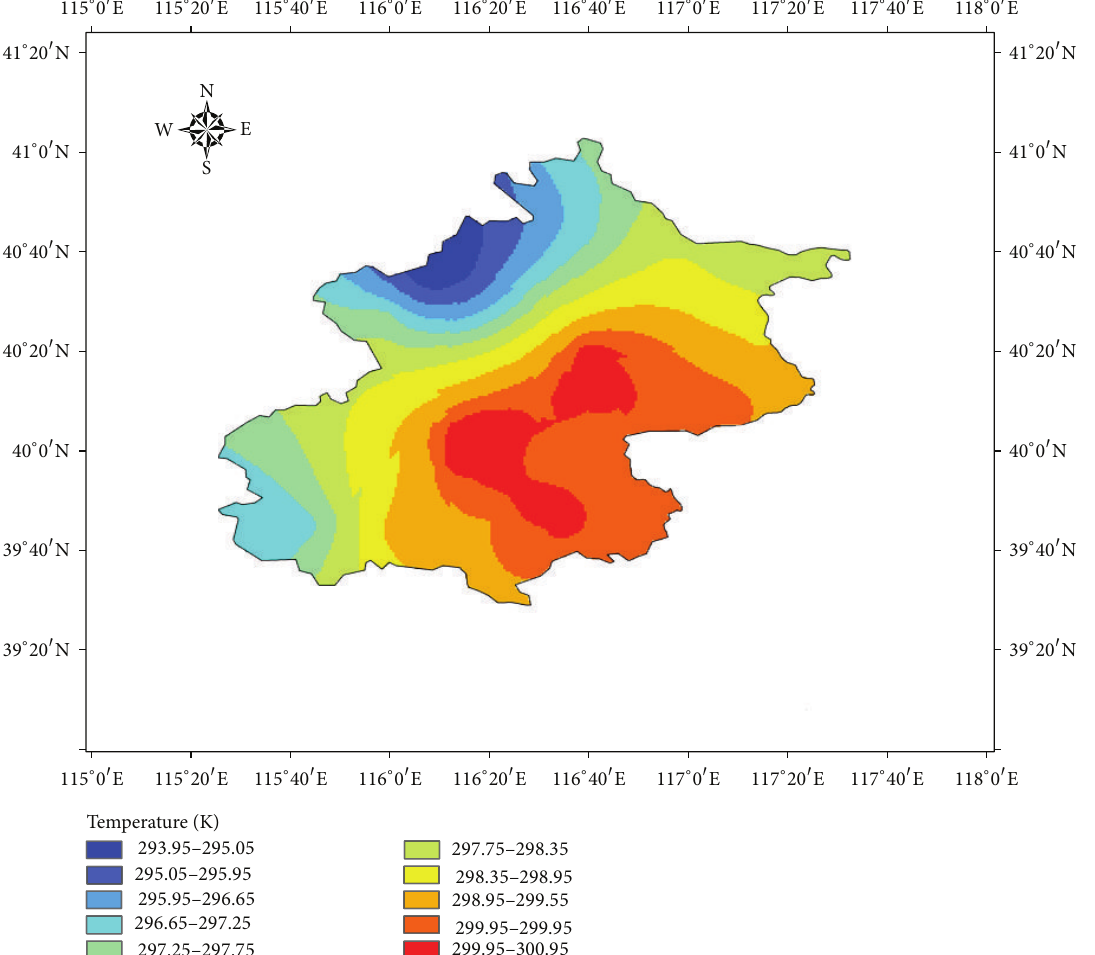
Figure 3: Spatial distribution of the observed daily mean temperature (K) from 01 to 02 July, 2003.